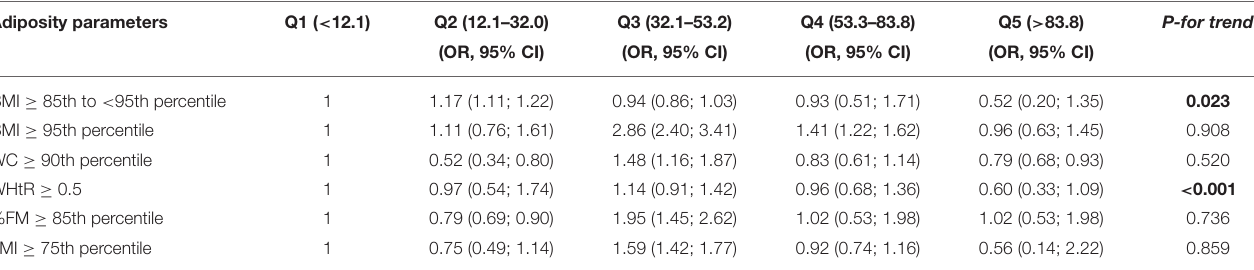
TABLE 6 | Association between flavonoids from cocoa-based products (mg/day) and adiposity parameters. Adiposity